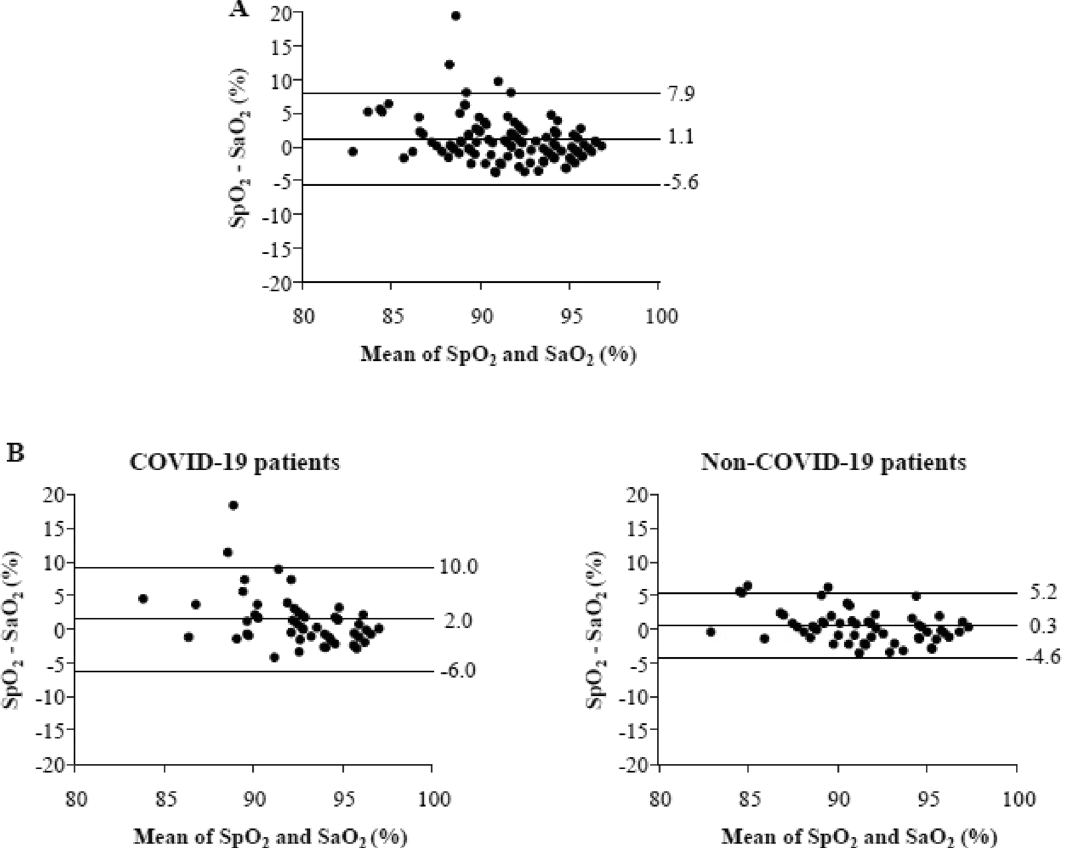
Figure 2. Comparison of pulse oximetry (SpO 2 ) and arterial oxygen saturation (SaO 2 ) measurements using the Bland–Altman method. The solid line represents the bias and the dotted lines represent the 95% limits